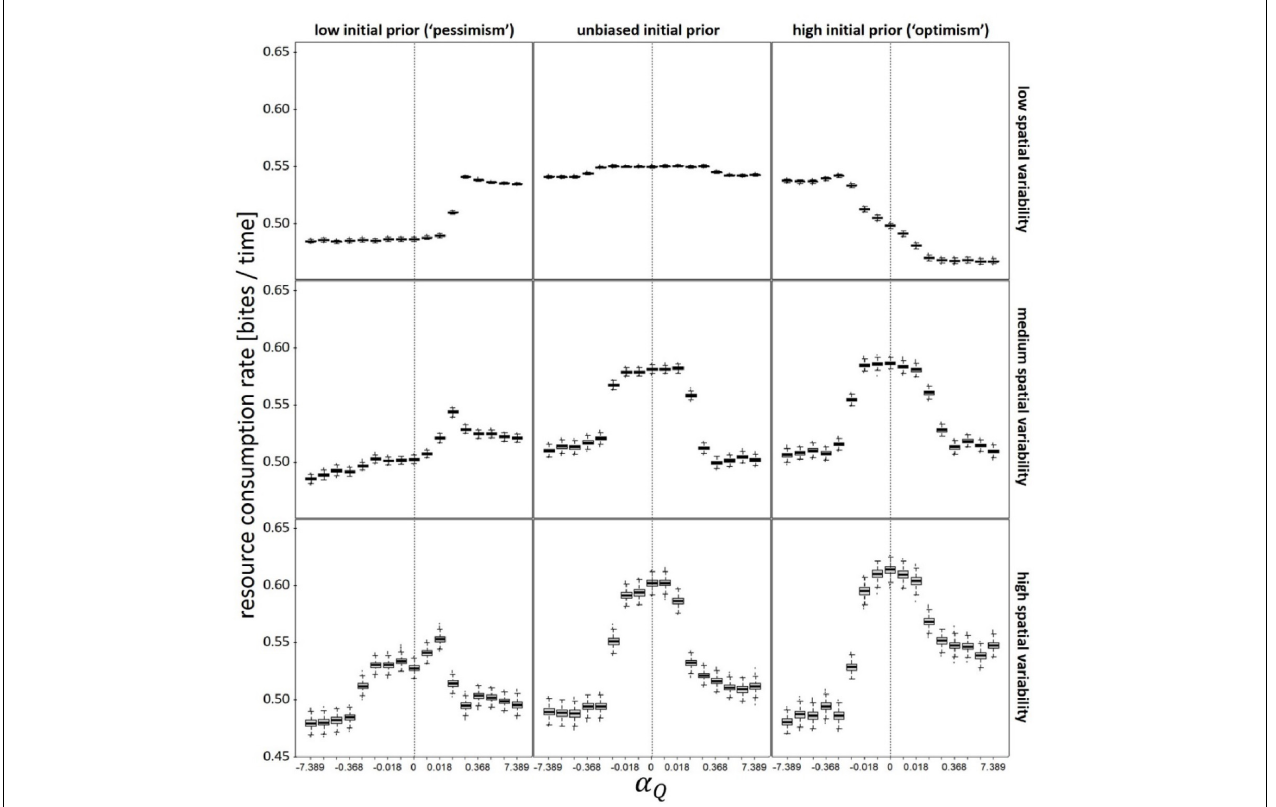
FIGURE 3 | Consumption (feeding) rate as function of valence-dependence for patch quality (positive values of α Q correspond to valence-dependent optimism whereas negative values correspond to valence-dependent pessimism). Vertical dashed lines denote unbiased learning ( α Q = 0). Different panels refer to different scenarios: low ( Q ( t = 0) = 50), unbiased ( Q ( t = 0) = 100), and high ( Q ( t = 0) = 150) initial prior belief (columns), and low ( CV ( Q ) = 0.1), medium ( CV ( Q ) = 0.5), and high ( CV ( Q ) = 1) spatial variability (rows). In each scenario, α T was kept constant at its optimal (fitness maximizing) value. T ( t = 0) = b T = 10; CV ( T ) = 0.5; P travel = t max − 1 ; other parameters and variables were as detailed in Table 1